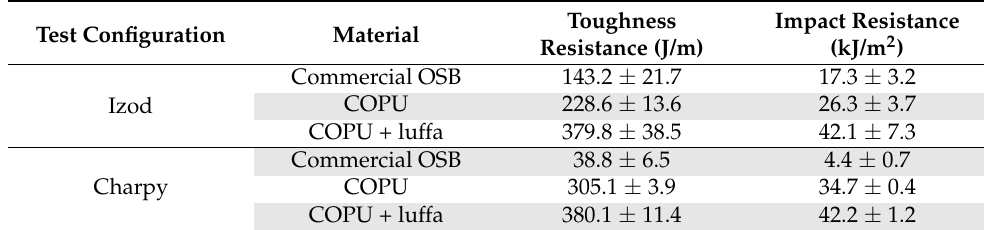
Table 1. Impact behavior for plain COPU resin, luffa reinforced COPU composite, and commer- cial